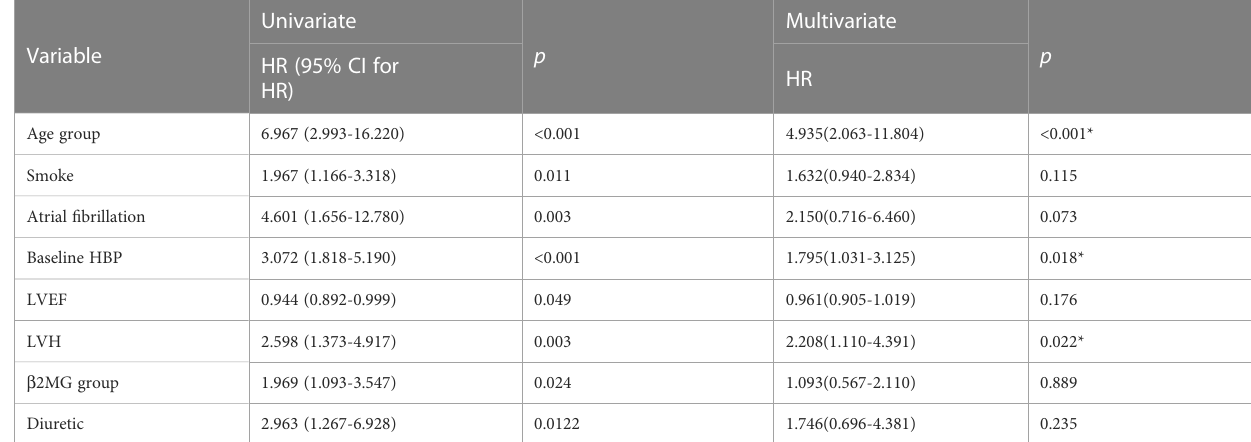
TABLE 3 Univariate and multivariate Cox analyses for OS of CVAEs in patients with NDMM in training cohort.